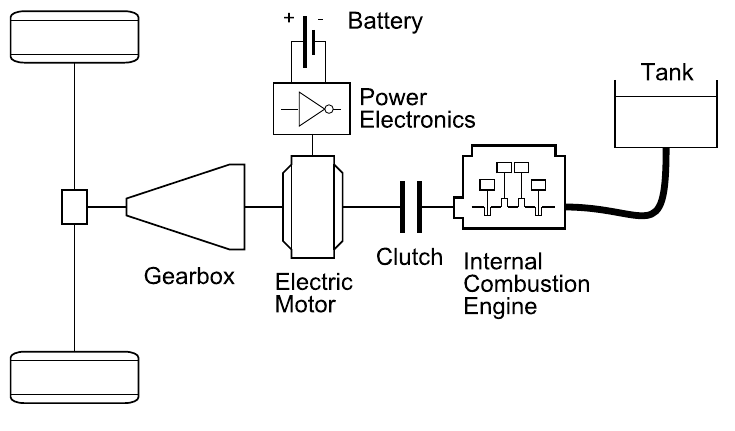
Hybrid electric vehicle (HEV) architecture considered in this paper: pre-transmission parallel